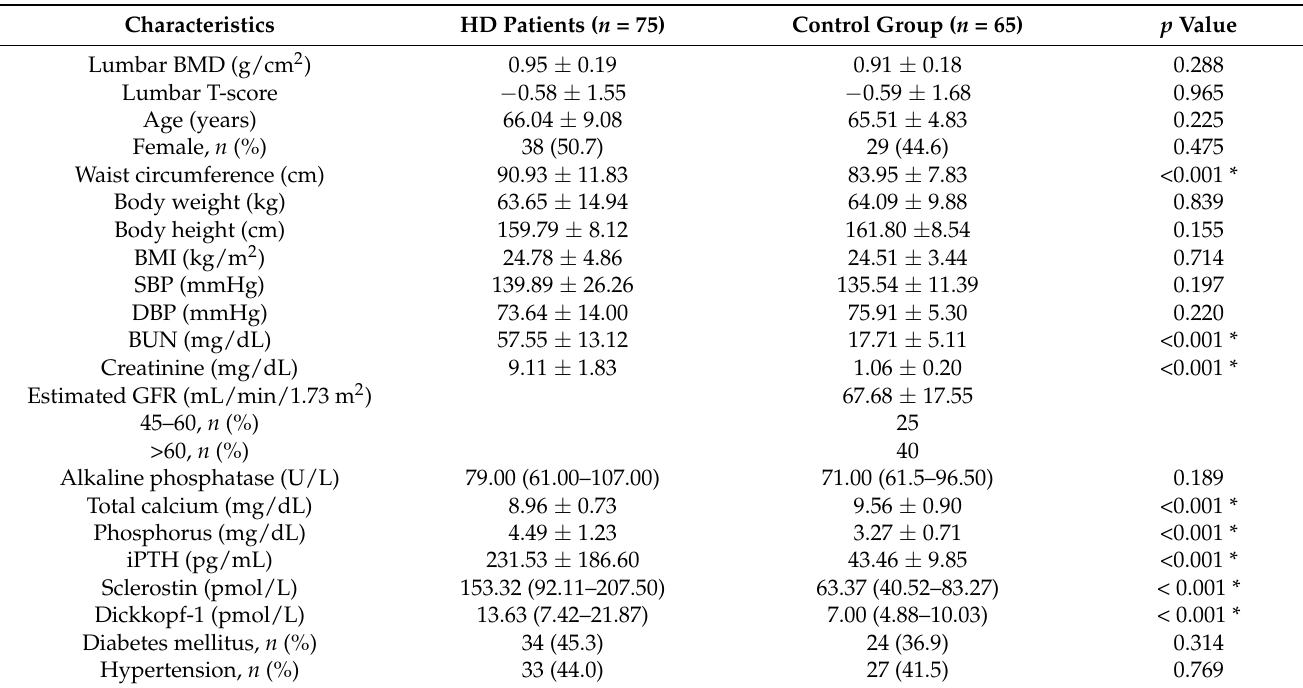
Table 1. Clinical characteristics of hemodialysis patients and control group.